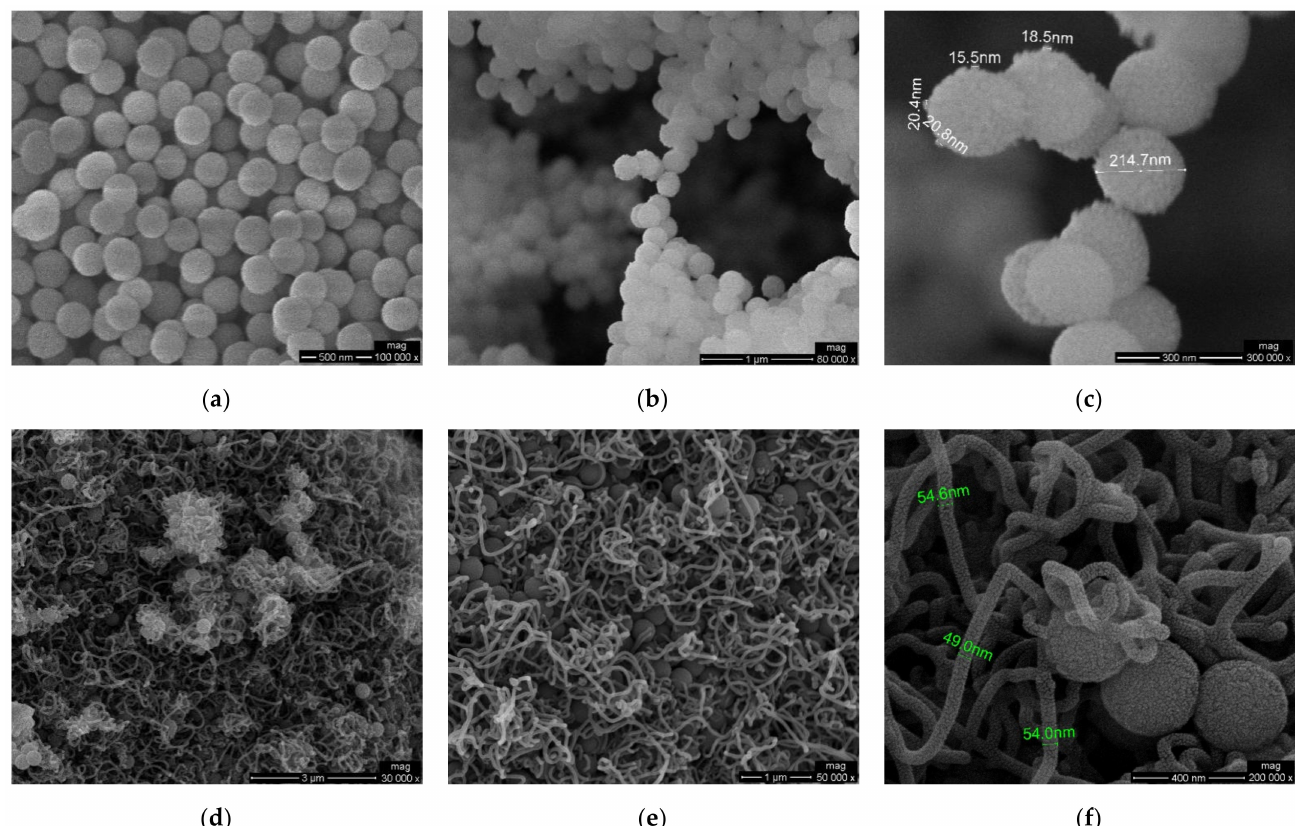
Figure 1. SEM images of ( a ) silica microspheres; ( b , c ) silica microspheres with iron oxide nanoparticles at different